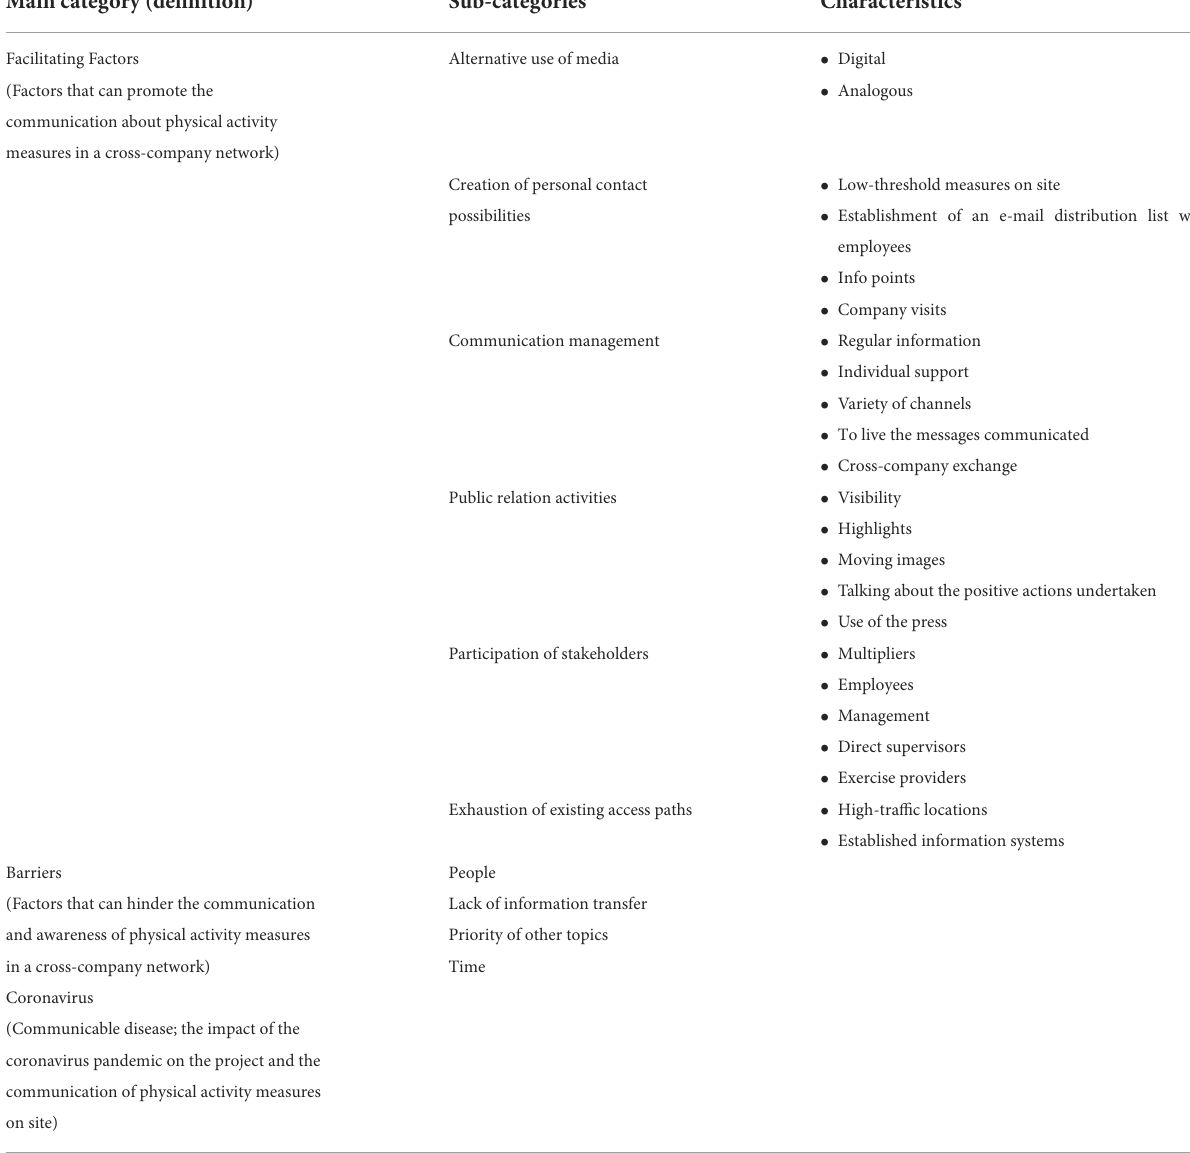
TABLE 5 Coding system: facilitation factors and